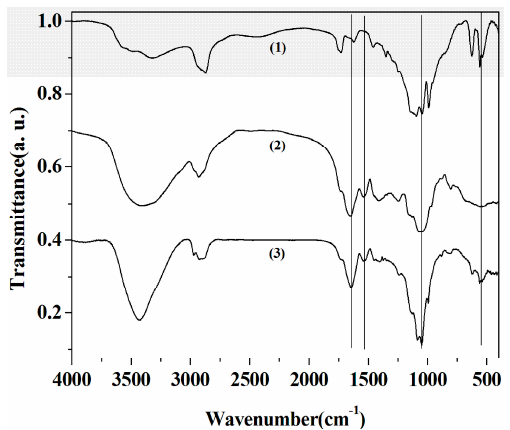
Figure 2. Fourier transform infrared spectroscopy (FTIR) spectrum of Cu 3 (PO 4 ) 2 · 3H 2 O matrices without laccase (Curve 1), free laccase (Curve 2) and laccase-incorporated nanoflower (Curve 3).